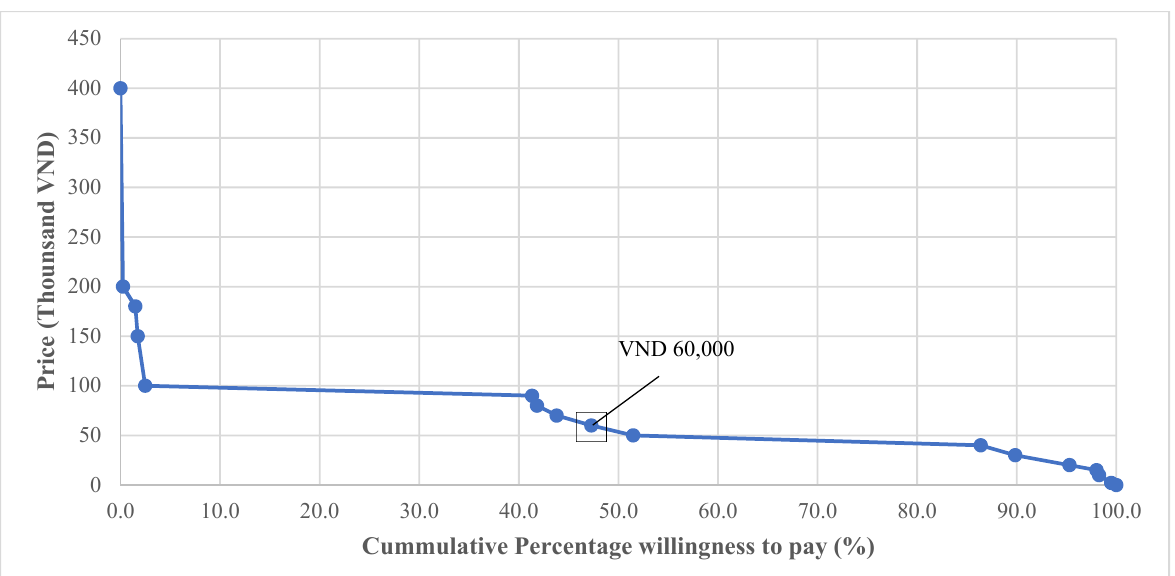
Table 4. Associated factors with WTP and the amount of